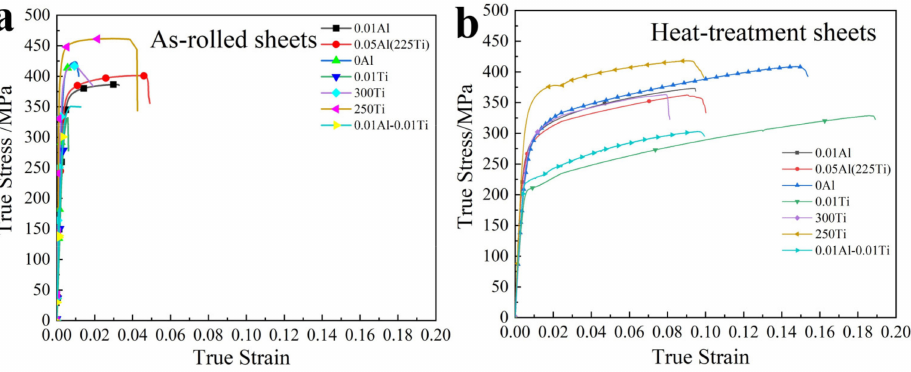
Figure 7. True stress–strain curves of ( a ) as-rolled sheets and ( b ) heat-treated sheets. Table 5. Mechanical properties of Mg-(Al-)Ti rolling sheets before heat